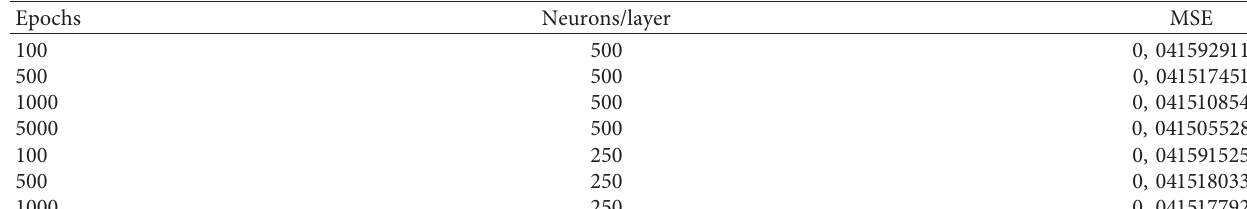
Table 6: Comparison of the numbers of epochs.